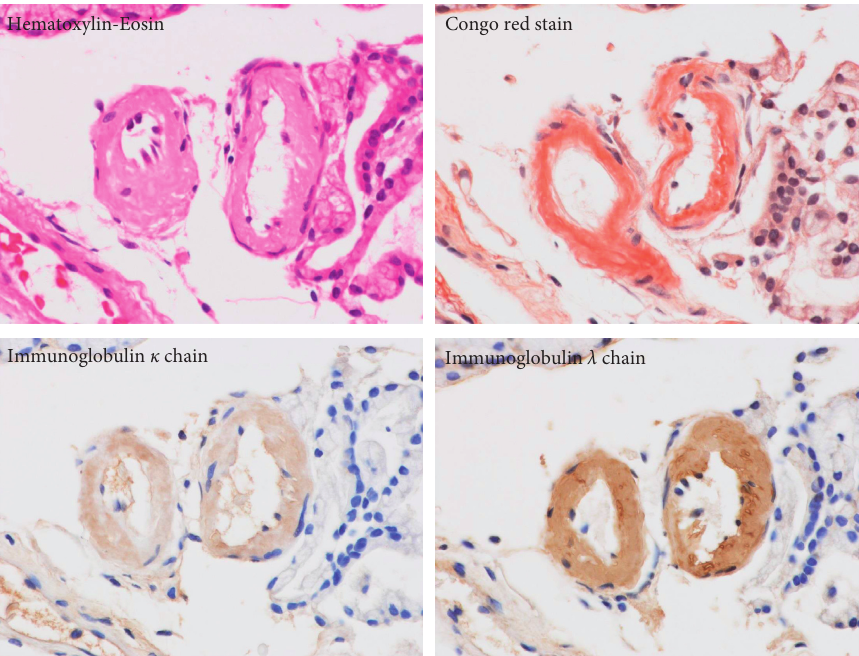
Figure 7: Amyloid deposits in the vascular wall. Amyloid deposits were found in the submucosal vascular walls of the duodenum. (a) Hematoxylin eosin. (b) Congo red stain. (c) Immunoglobulin κ chain. (d) Immunoglobulin λ